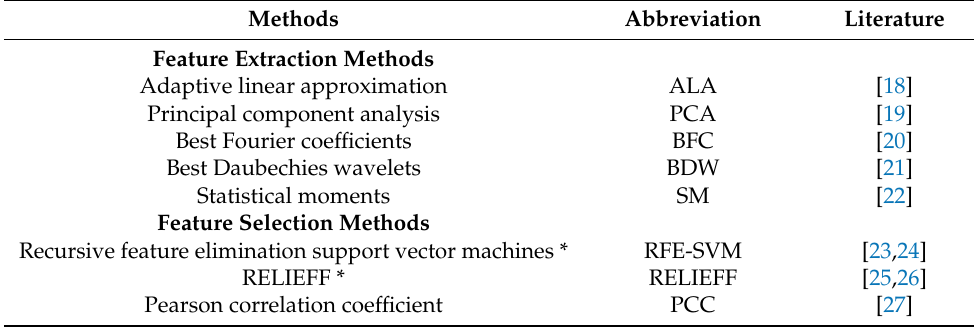
Table 2. Feature extraction and selection methods of the automated toolbox